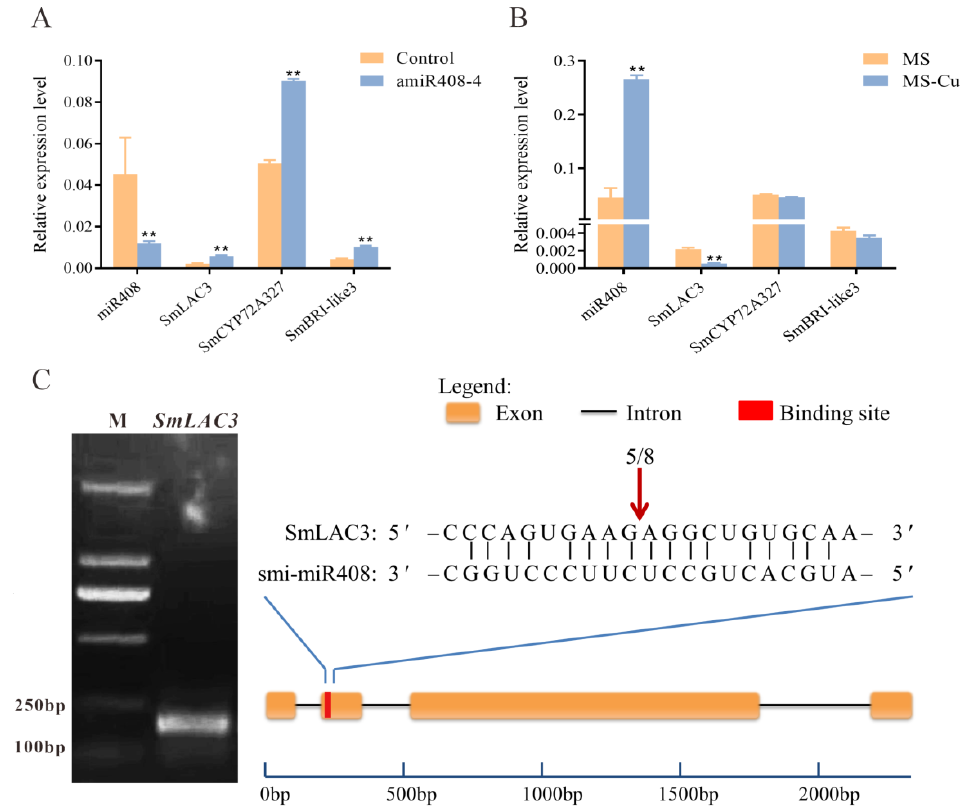
Figure 5. Validation of Sm -miR408 target genes. ( A ) Relative expression levels of the Sm-miR408 putative target genes in amiR408 lines compared to control lines. ( B ) Relative expression levels of the Sm -miR408 putative target genes under normal and copper starvation conditions. ( C ) Sm -miR408 cleavage site in SmLAC3 mRNA validated by 5’ RLM-RACE. For RT-qPCR, all data represent the means of three biological replicates, with error bars indicating SD. Significant differences were determined by Student’s t -test (** p < 0.01).